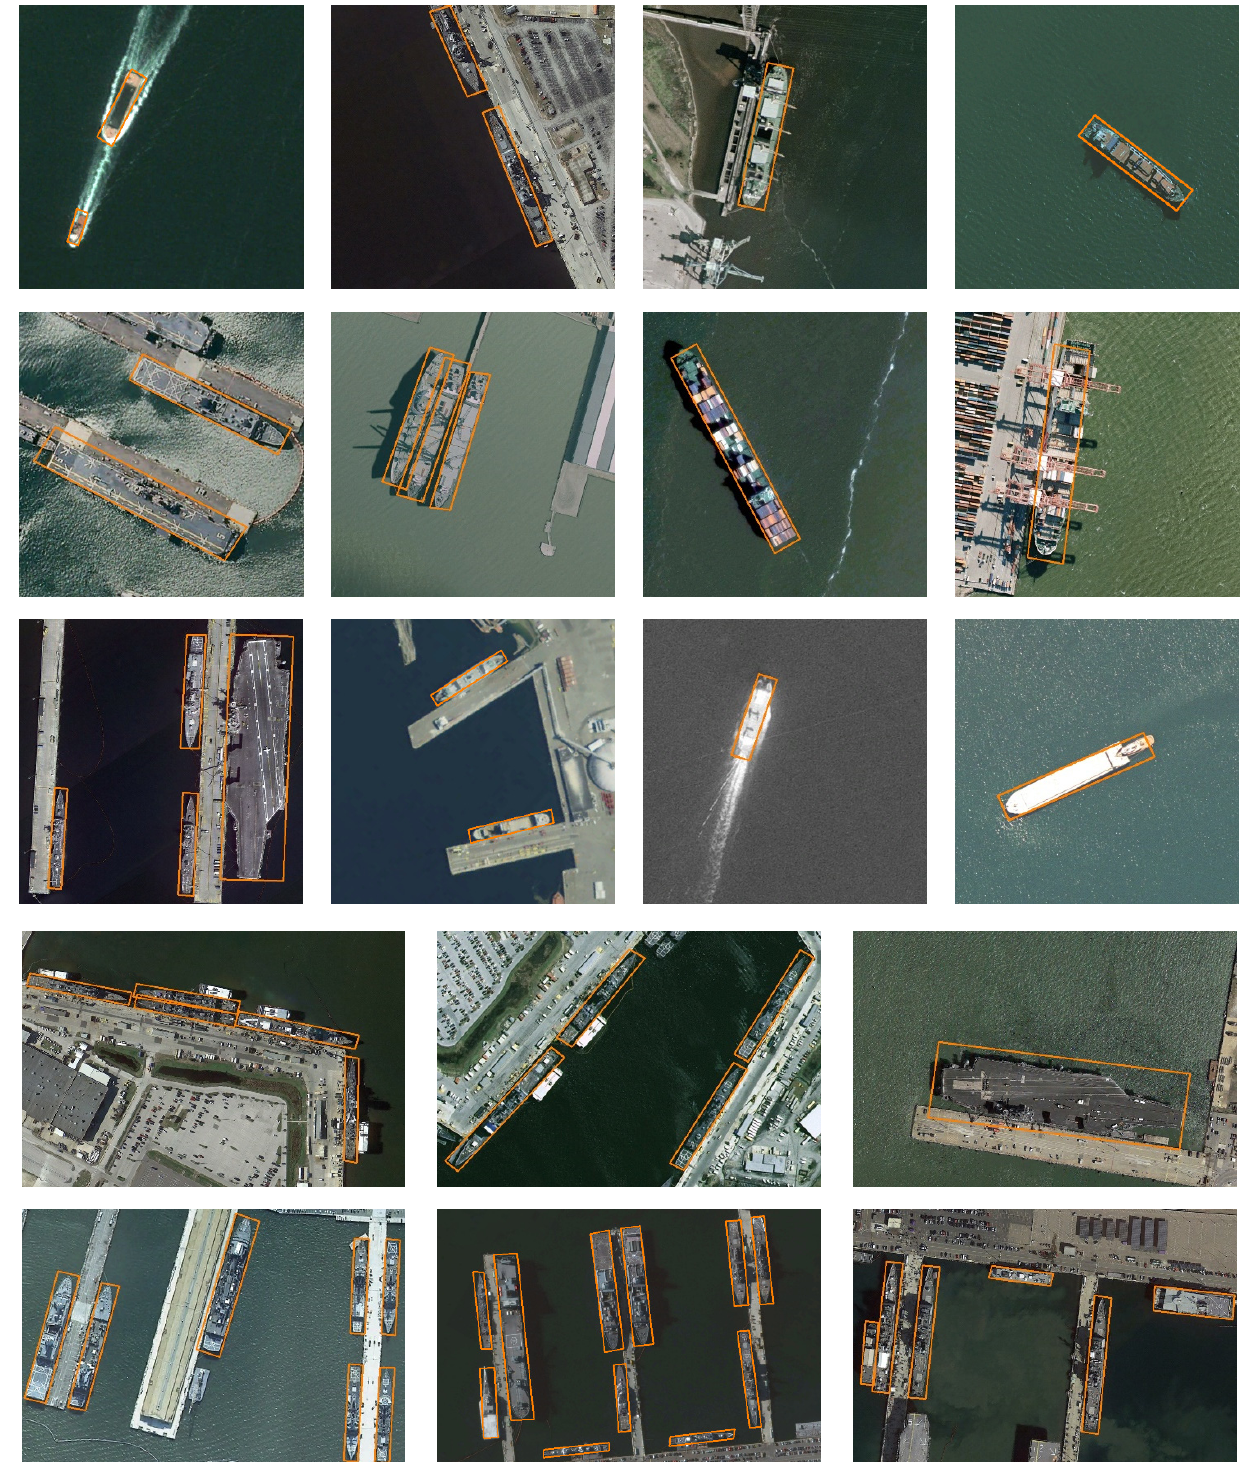
Figure 9. Some visual results of detection with TPR-R2CNN (double head with classification fusion) network (the threshold score is 0.5) for the HRSC2016 dataset.